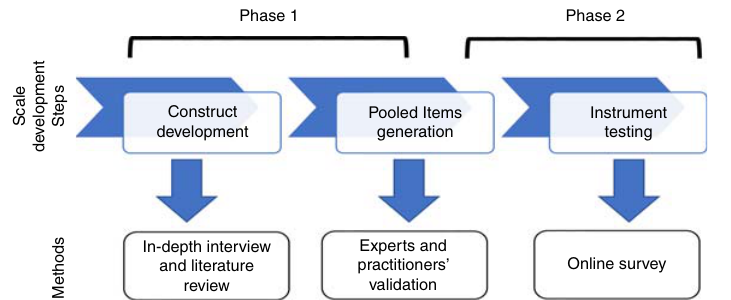
Figure 1. Research